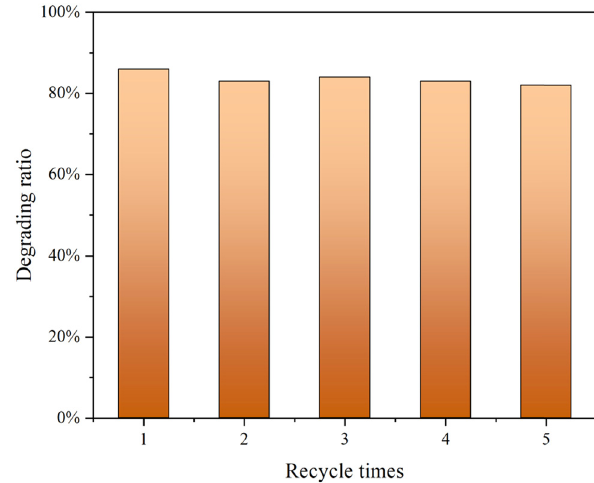
Figure 9: Photocatalytic stability in the removal of gaseous toluene by GC - RGO -